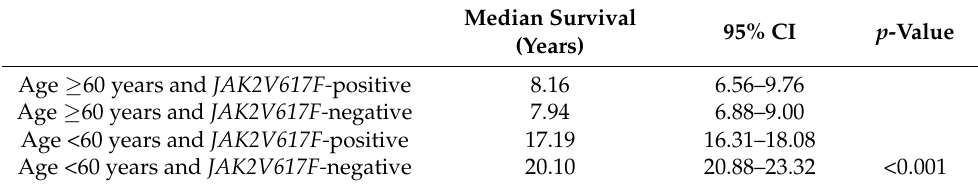
Median Survival (Years)